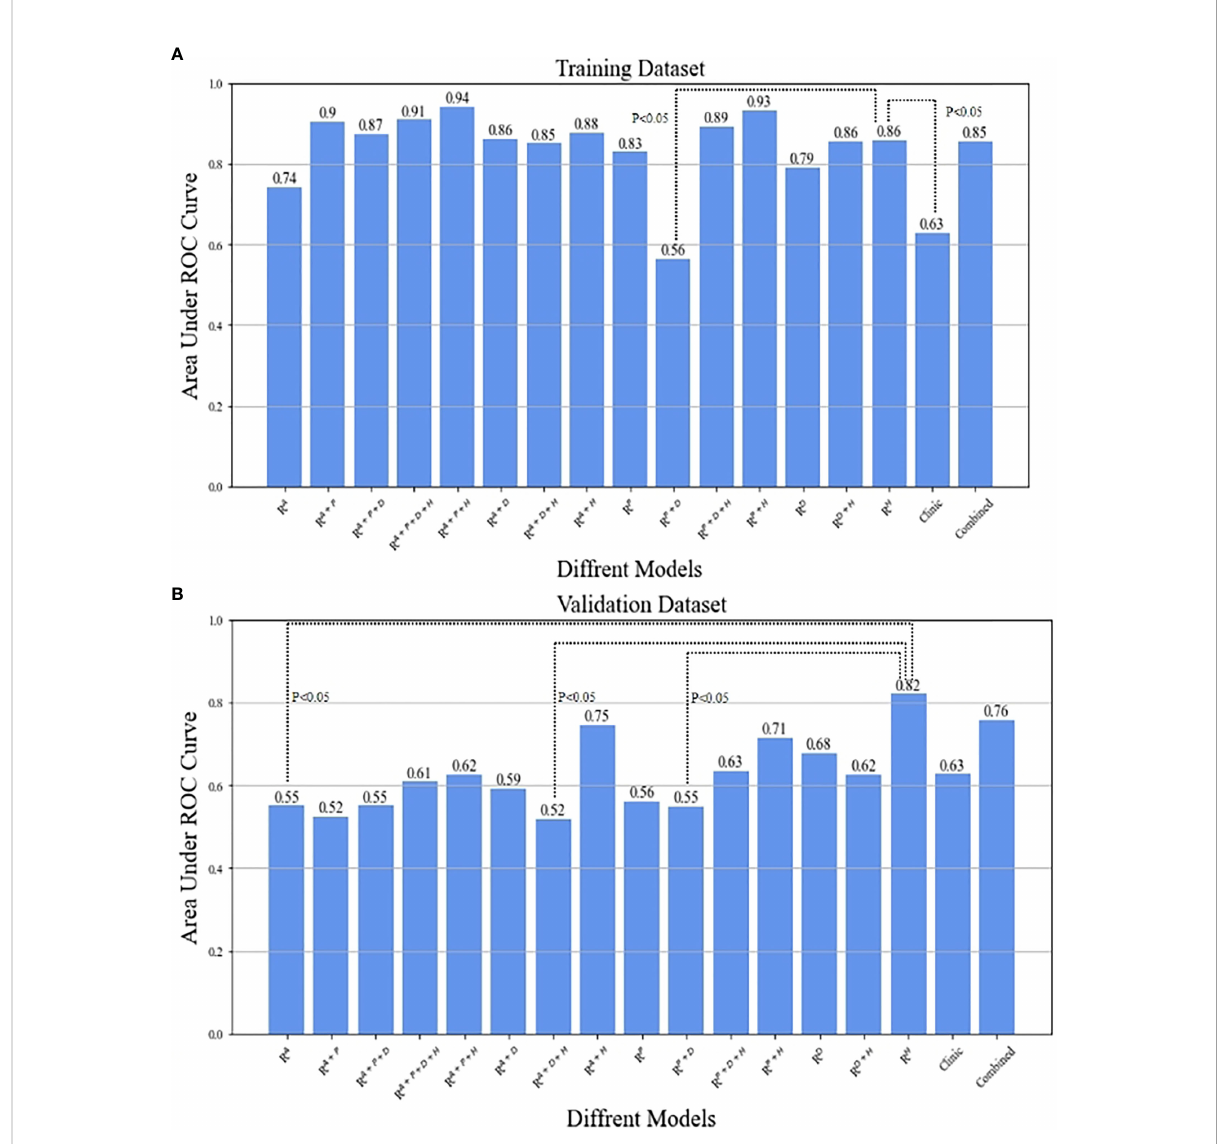
FIGURE 3 The comparison between R HBP radiomics model in predicting b -catenin mutation and the other models by means of Delong test in the training (A) and validation (B)